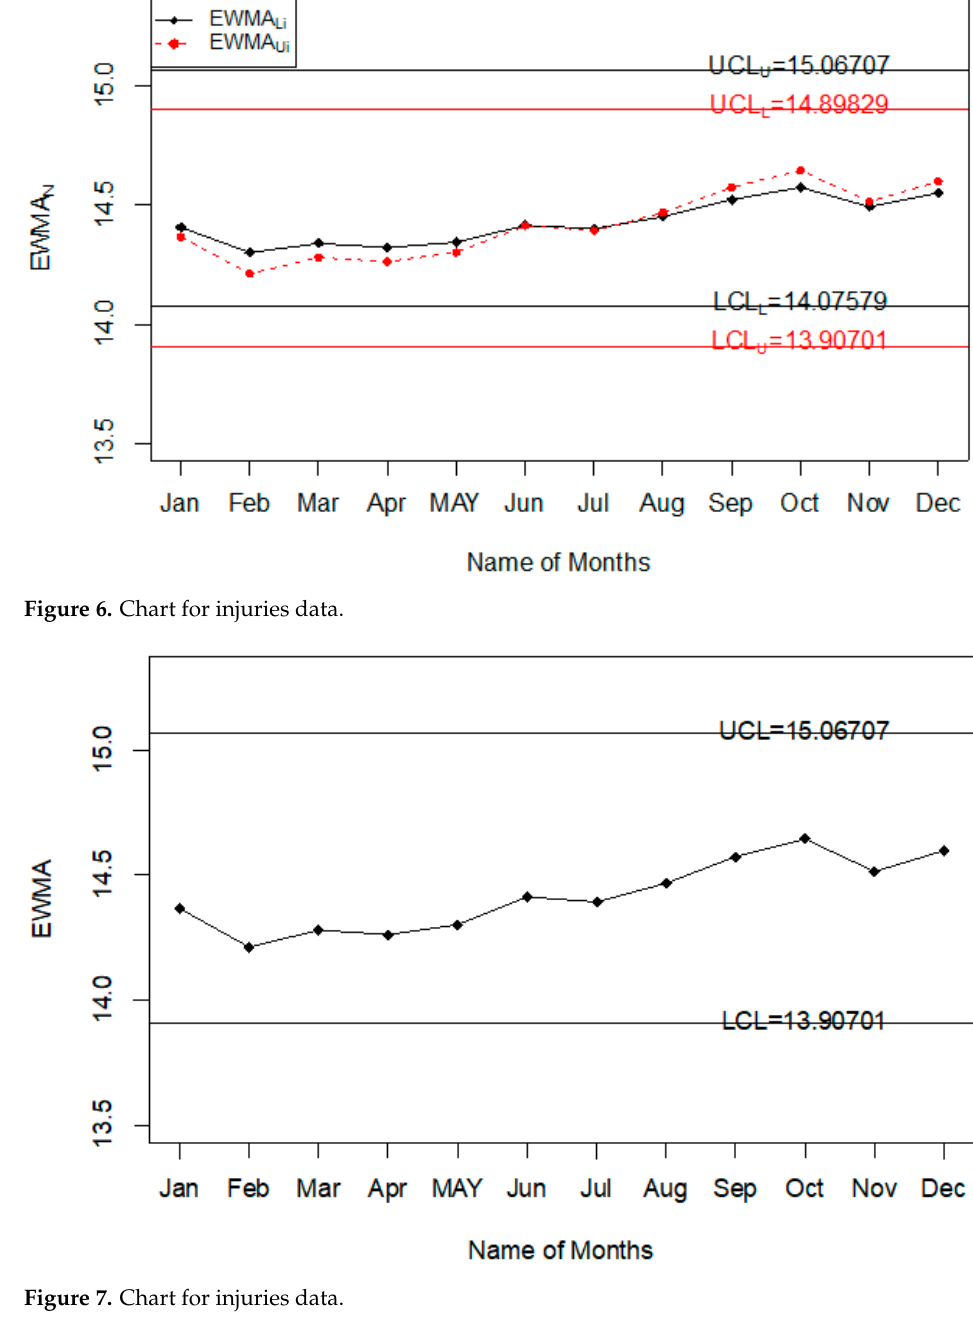
Figure 7. chart for injuries data.